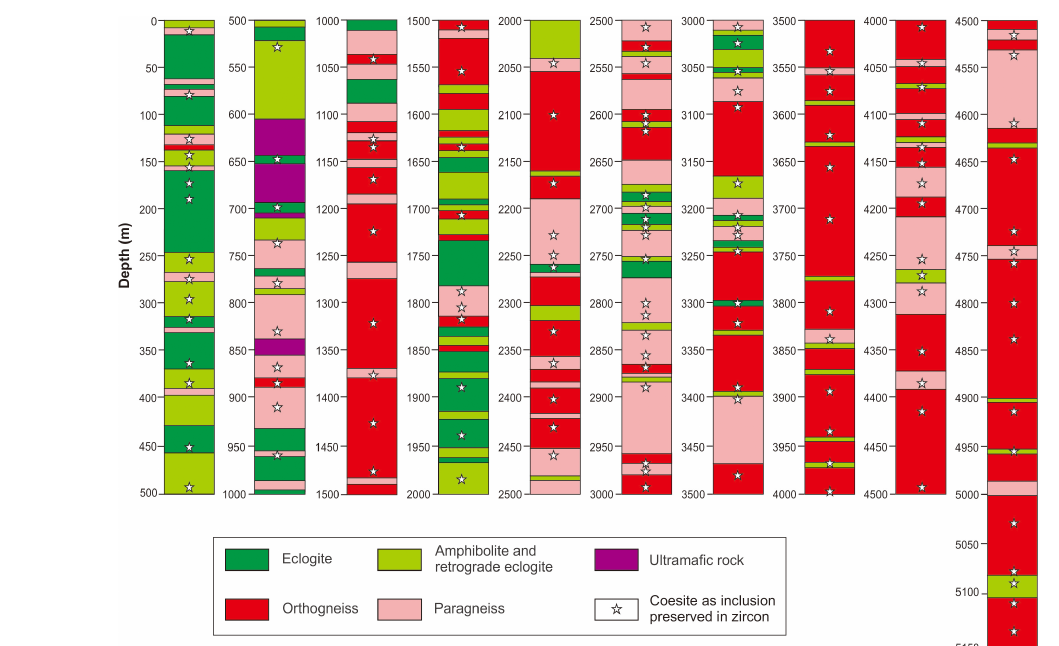
Figure 3. Simplified lithological profile of the CCSD-MH in Donghai County (Liu et al.,